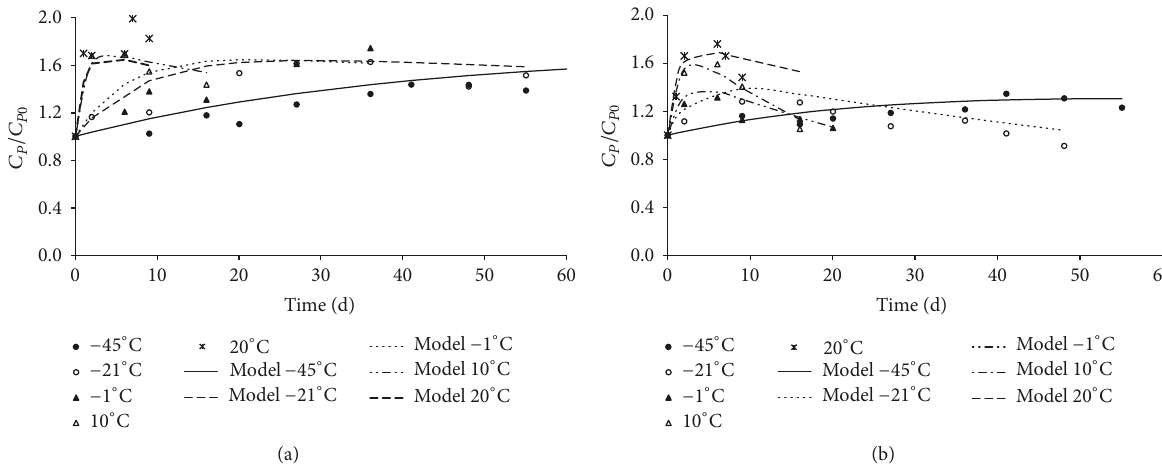
Figure 4: Adjustment of the two-consecutive-reaction kinetic model to TPP content in (a) unprocessed and (b) blanched broccoli during storage at different